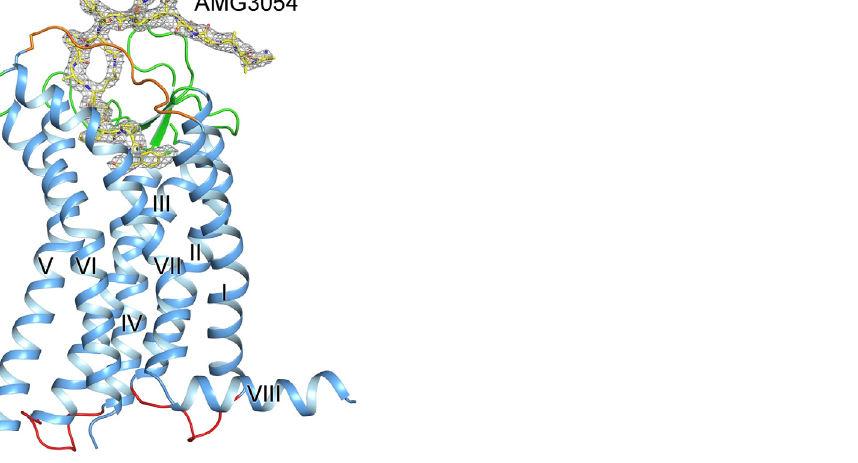
Figure 1. Structural determination of the apelin receptor with the peptide agonist AMG3054.